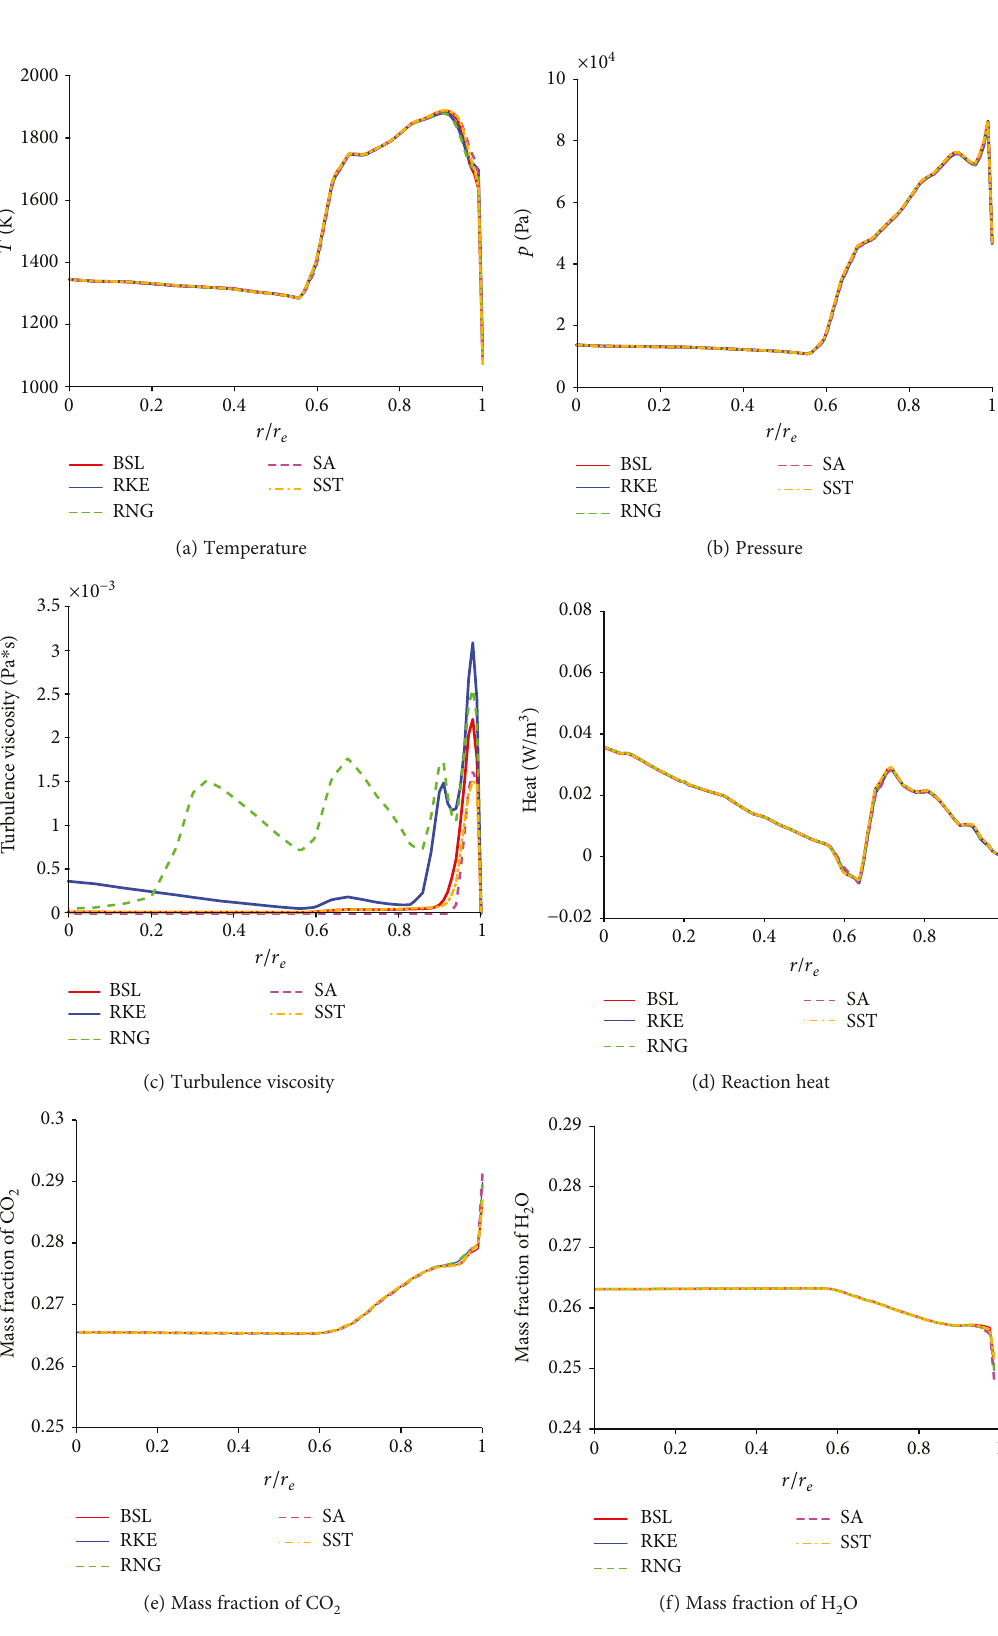
Figure 4: Radial parameter distribution at the nozzle exit for di ff erent turbulence